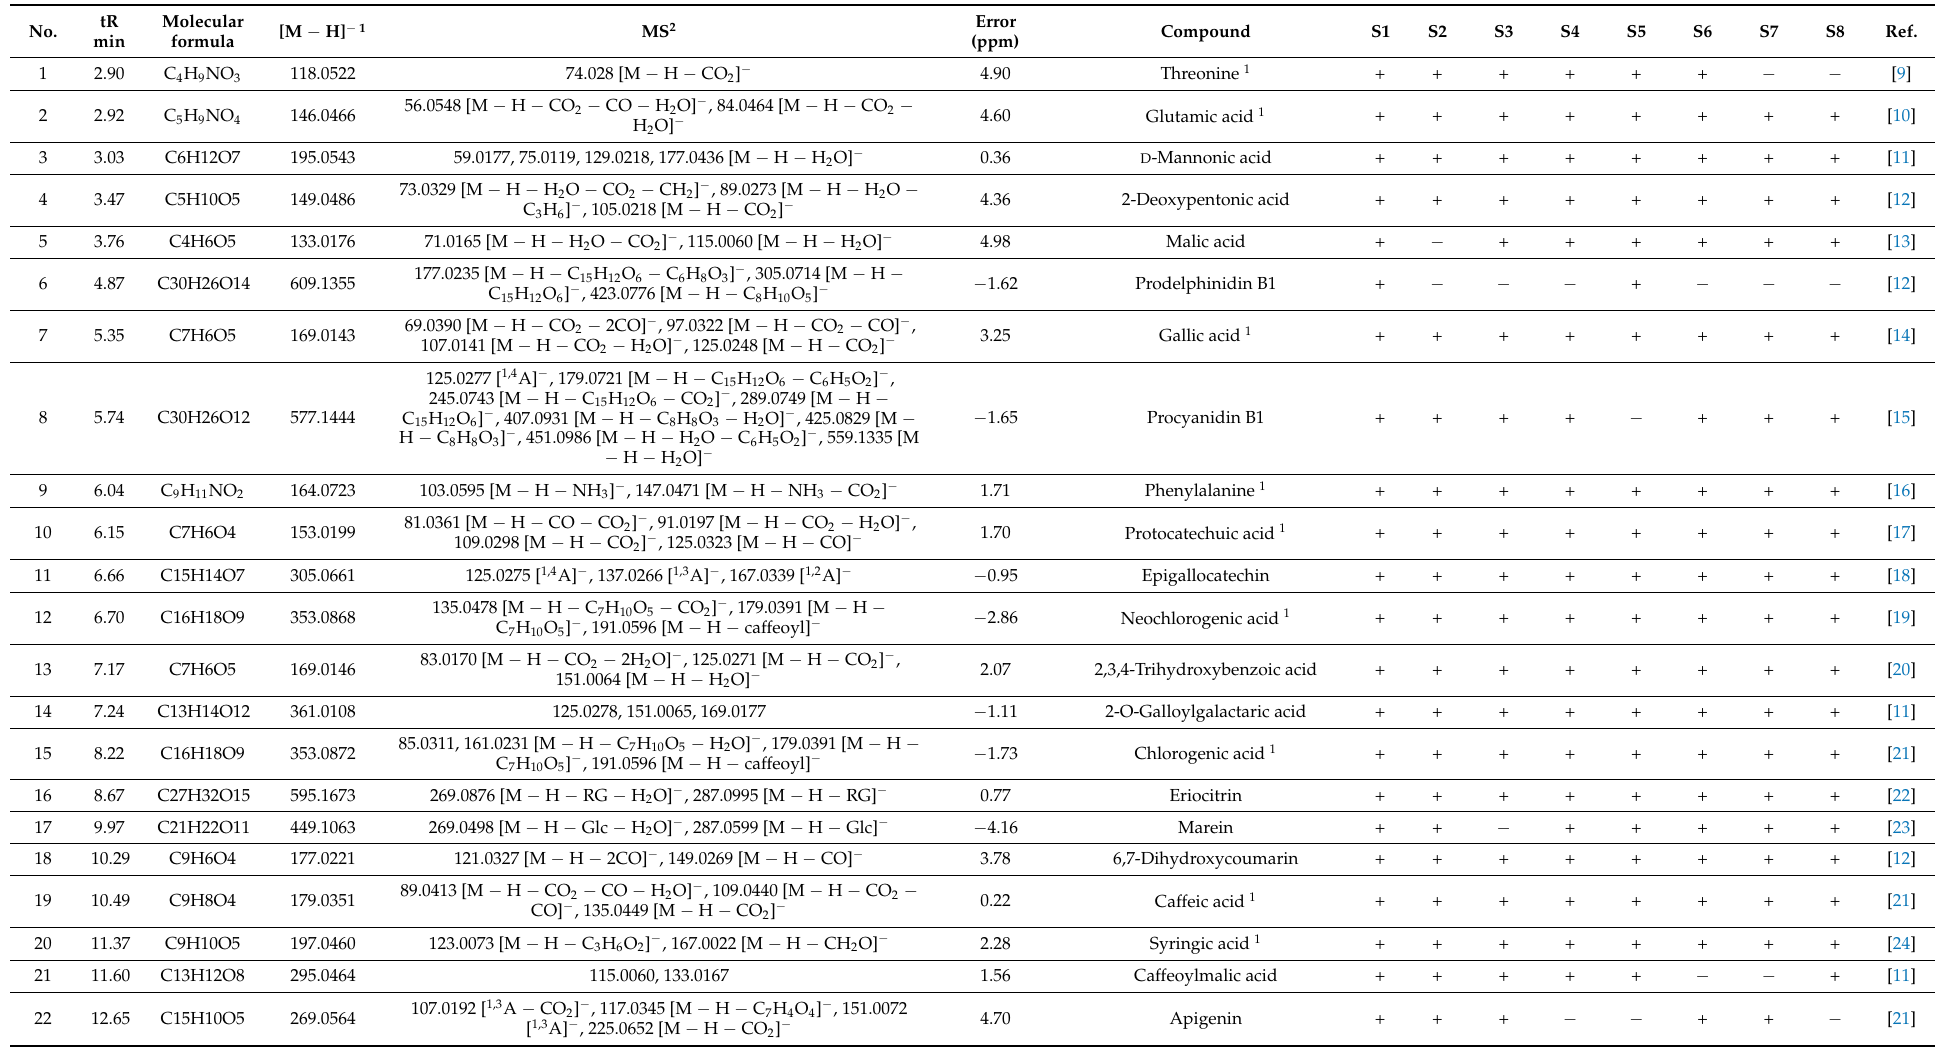
Table 1. Identification of 46 constituents in Lysimachiae Herba by UFLC-triple